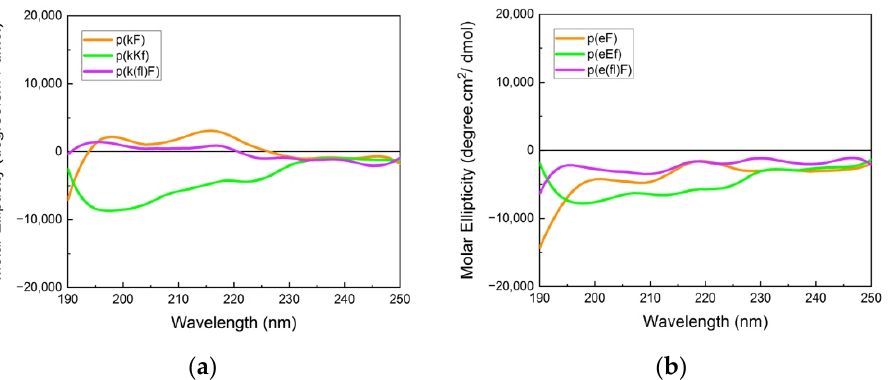
Figure 2. Circular dichroism (CD) spectra of ( a ) polycation and ( b ) polyanion sequences. Signal cancellation from opposite chirality results in almost a flat signal; otherwise, due to the like-charged groups on each patterned sequence, a random coil signal (usually with a minimum (or maximum for D-chirality) at 195 nm) can be observed.